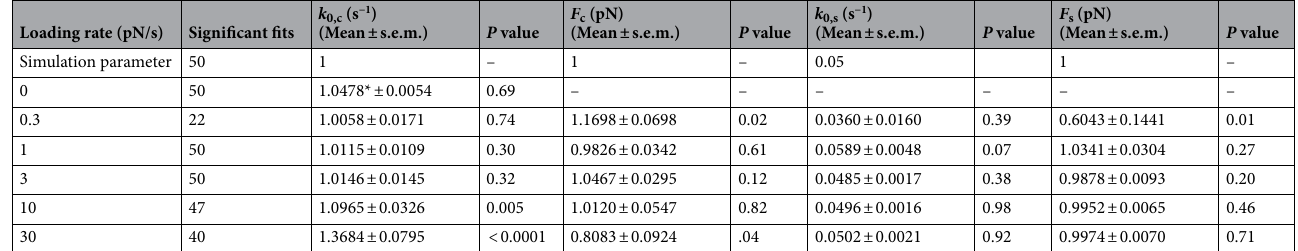
( k off,c-s ( F = 0 ) = k 0,c per Eq. (16) and n ( t ) = N e − k 0,c t , equivalent to the unloaded slip bond case, Fig. 3a, dark purple ). We found that the nature of the time to detach distribution histograms was a strong function of loading rate. Low external loading rates ( f = 0.3 pN/s, Fig. 4b, upper left ) exhibited a nearly exponential distribution of unbinding times, like the other bond types we have discussed, and high external loading rates ( f = 30 pN/s, Fig. 4b, lower right ) corresponded to a large Gaussian-like distribution of unbinding events at longer times. It is in the intermediate loading rate regime that two separate peaks, coming from the separate, significant contribu- tions from the catch bond (short events) and slip bond (long events) behaviors, respectively, emerge (Fig. 4b, upper right and lower left ). We also plotted the force-free and force-dependent dissociation of simulated slip bonds (same data as Fig. 4b) as a function of their time to dissociate ( n ( t ) ). We fit these data to n ( t ) = N e − k 0,s t and Eq. (18a) (Fig. 4c, Table S3, and Supplementary Information for details), respectively. As we did with slip bonds, we input the values for N and f as fixed parameters in the fit and repeated the simulations 50 times. Unlike the case of slip bonds, we found that non-linear least squares regression was unable to uniquely determine fitting parameters in multiple of the simulated data sets at lower and higher loading rates (Supplementary Information). Of the 50 simulations, we found that only 22 of the simulated data sets were well-fit by Eq. (18a) for low loading rate (0.3 pN/s) and 40 of the simulated data sets were well-fit by Eq. (18a) for high loading rate (30 pN/s). We suspected that the errors in the fits were due to an “overfitting” of the data, that is, the number of data points become too few in either the catch bond (short events) or slip bond (long events) regimes, so the model effectively has more parameters than can be justified by the data. Overfitting makes the model insensitive to the data, and the fit values become unreasonably small or large. To investigate this hypothesis, we determined whether the force at unbinding was above or below the catch-slip transition force, F c-s , for each unbinding event to classify whether the bond dissociated in the catch ( F < F c-s ) or slip ( F > F c-s ) regime. We plotted the mean number of bonds dissociating in the slip regime for the 50 simulations with N = 1000 total bonds (Fig. 4d, purple dashed line ). We found that most of the bonds dissociated in the catch bond regime (Fig. 4d, purple dashed line ) when the loading rate was low, corresponding to an exponential-like distribution of unbinding events (Fig. 4b, upper left). At high loading rates, the fraction of bonds that dissociated in the slip force regime was high (Fig. 4d, purple dashed line ), corresponding to a large Gaussian-like distribution at relatively longer times (Fig. 4b, lower right) and similar to slip bonds (Fig. 3b, lower right). Together, these data suggest that the slip bond parameters have little effect on the unbinding behaviors at low loading rates and that the catch bond parameters have little effect on the unbind behaviors at high loading rates. Thus, attempting to fit Eq. (18a), which contains both the slip and catch bond-related parameters, is less effective at low or high loading rates. Moreover, even when the low and high loading rate data are well-fit by Eq. (18a), i.e., the non-linear least squares regression was able to uniquely determine fitting parameters, we found that the standard errors of those fits tend to be significantly larger than for intermediate loading rates (Tables 3 and S3, and Supplementary Infor- mation for more details). Therefore, these results suggest that one must use intermediate loading rates, i.e., load- ing rates for which a significant number of bonds dissociate in the catch and slip regimes (Fig. 4d, purple dashed line ), to determine the biophysical properties of catch-slip bonds, which is consistent with previously reported results 12,28 . The loading rate for which 50% of the bonds dissociates at the catch and slip bonds regime is given by